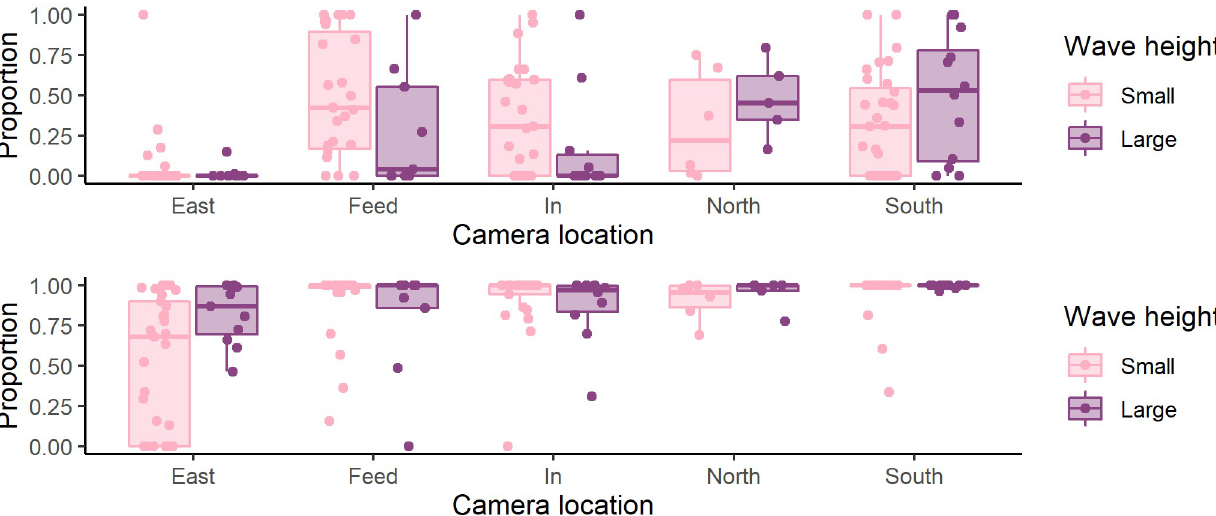
Fig 8. Proportion of time per video where “Many” (top panel) or “Any” (bottom panel) salmon were recorded. Light boxes indicate small waves and dark boxes indicate large waves. Dots are raw data and boxes and whiskers represent quartiles. Wave height was split at 1.1 m with “Small” waves being up to and including 1.1 m tall and “Large” waves being taller than 1.1 m. This was an approximate 50/50 split of the available data, and does not necessarily represent biological significance. Statistics are carried out using continuous wave parameters.